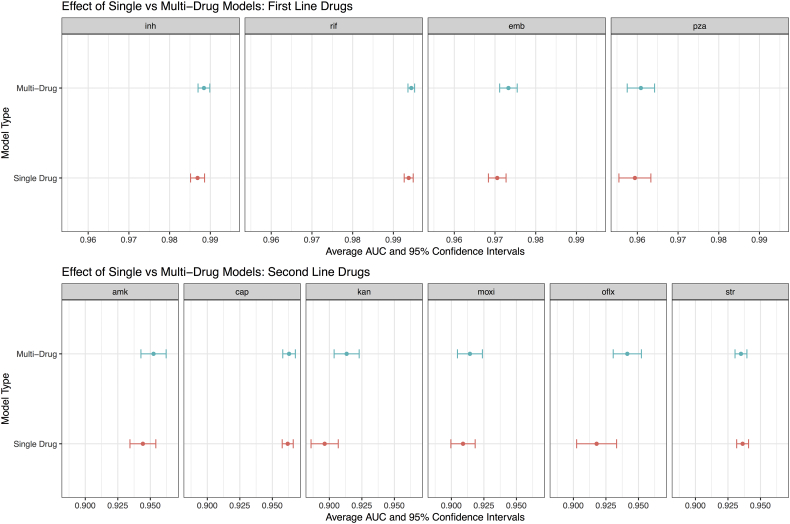
Comparison of tuberculosis drug resistance predictive performance between single drug and multidrug models. Area under the ROC curve classification performance and 95% confidence intervals during repeated cross-validation for the multidrug WDNN predicting resistance for all drugs simultaneously and for the single drug WDNN.